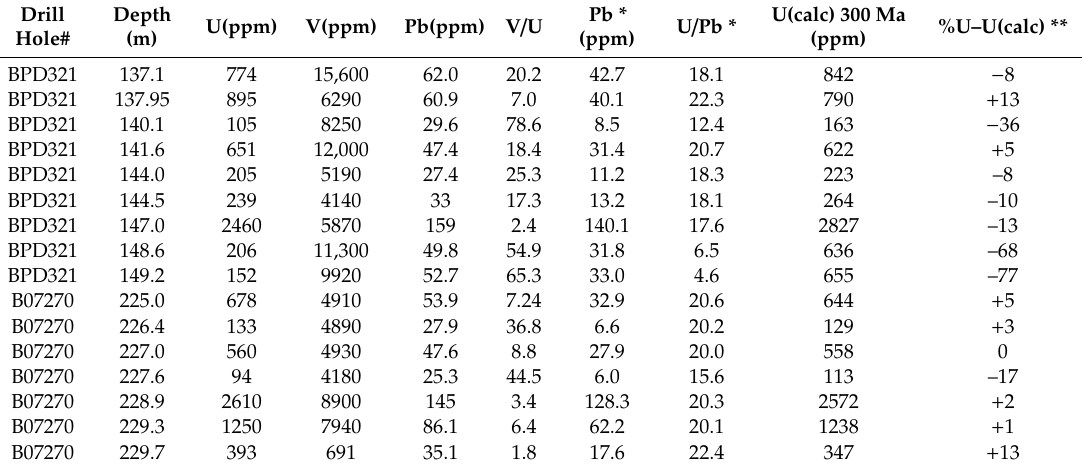
Table 3. Downhole variation of U, V, Pb and calculated U based on radiogenic